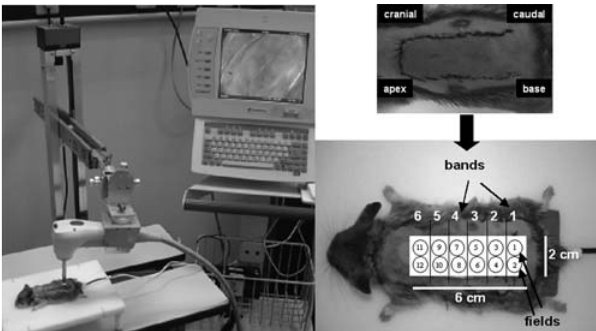
Figure 1 - Hamster skin flap model. Left side: the Cytoscan probe fixed by a mechanical device on the dorsal part of the animal. Right side: division of the skin flap into 12 fields from the caudal to cranial